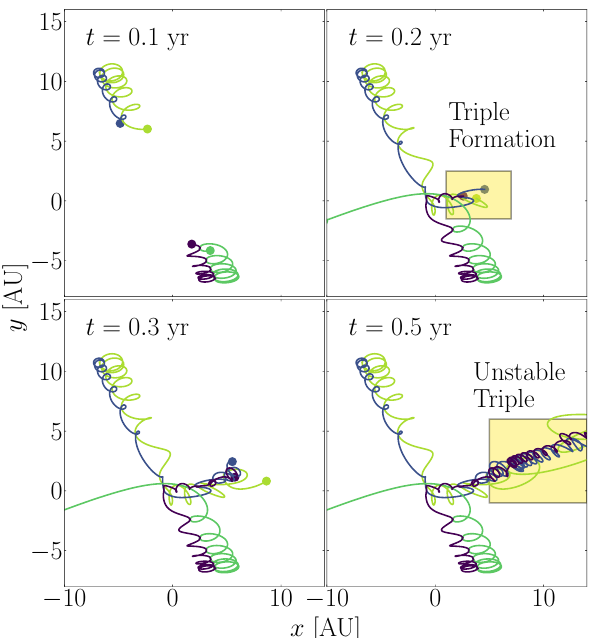
Figure 10. Binary–binary interaction involving four BHs in a dense star cluster. After the close encounter, one BH is ejected and the remaining three BHs form an unstable triple. Taken from Figure 2 in Arca Sedda et al., A&A, 2021, 650, A189, reproduced with permission ©ESO